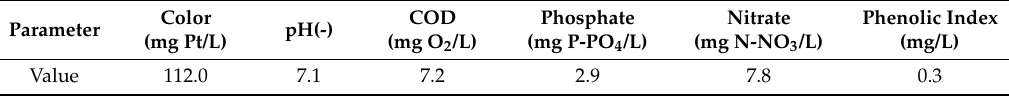
Table 2. Physical–chemical properties of WWTP (wastewater treatment plant) ffluent.